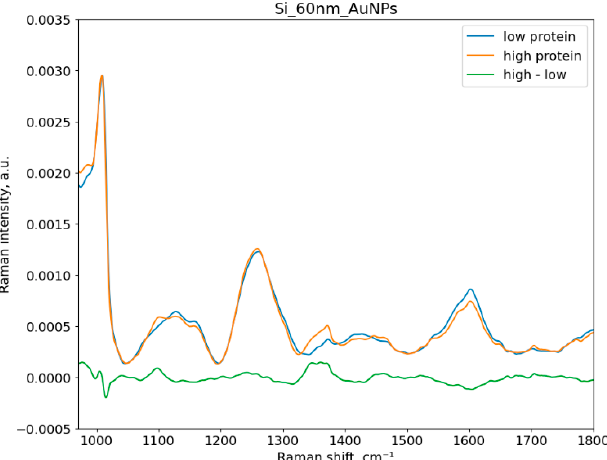
Figure 5. Average SERS spectra of urine samples with the low and the high protein groups with the spectrum of their difference for the silicon substrates. The protein threshold is 300 mg/L. Si_60nm_AuNPs means 60 nm Au NPs on the silicon substrate.